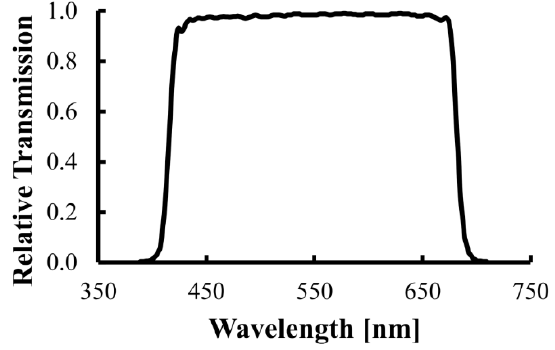
F IGURE 2. Relative transmission of the UV-/IR-Cut filter (Baader). Only light between 400 nm and 700 nm can transmit the filter (changed according to Baader Planetarium 2017).